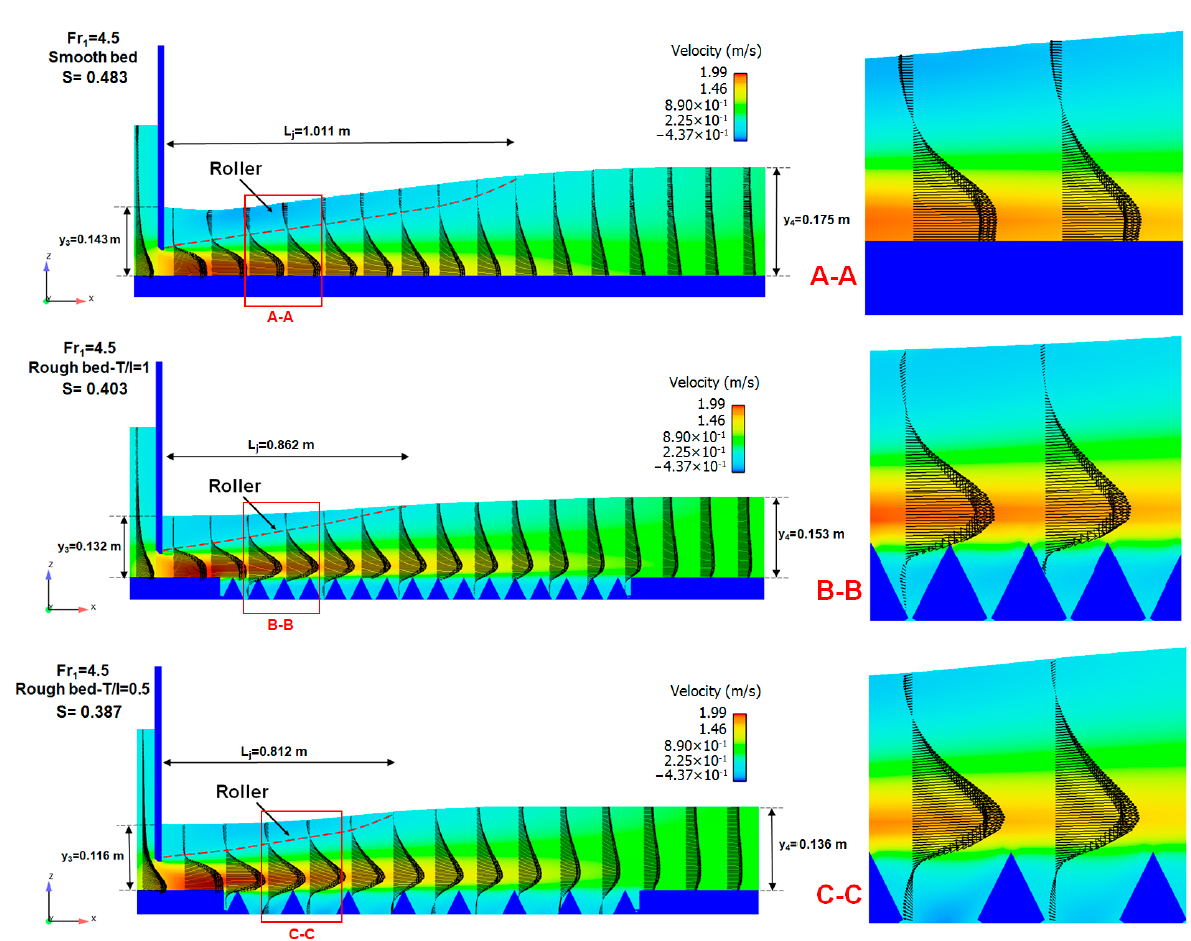
Figure 11. Typical horizontal velocity profiles in a submerged hydraulic jump on smooth bed and triangular macrorough- nesses.